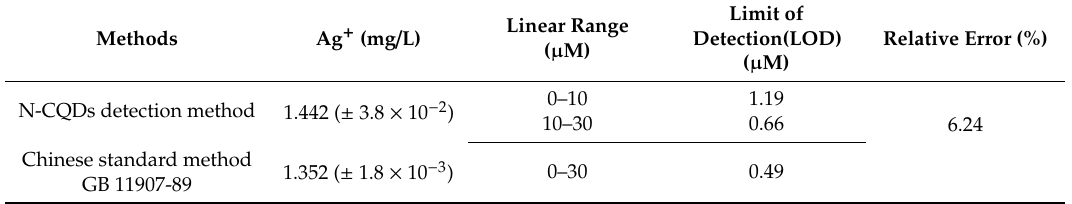
Table 1. Results of the measurement of Ag + concentration in food packaging